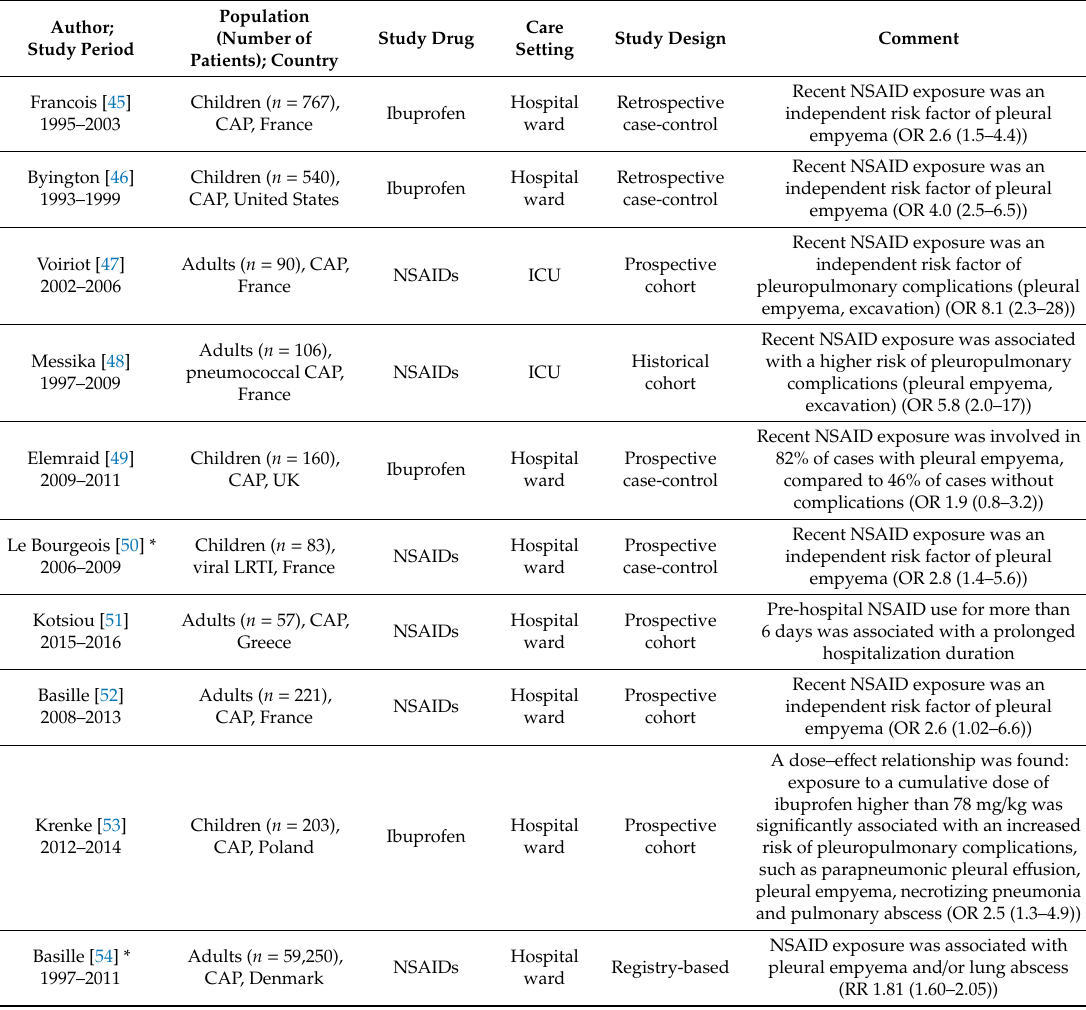
Table 1. Studies exploring the impact of pre-hospital exposure to NSAIDs in lower respiratory tract